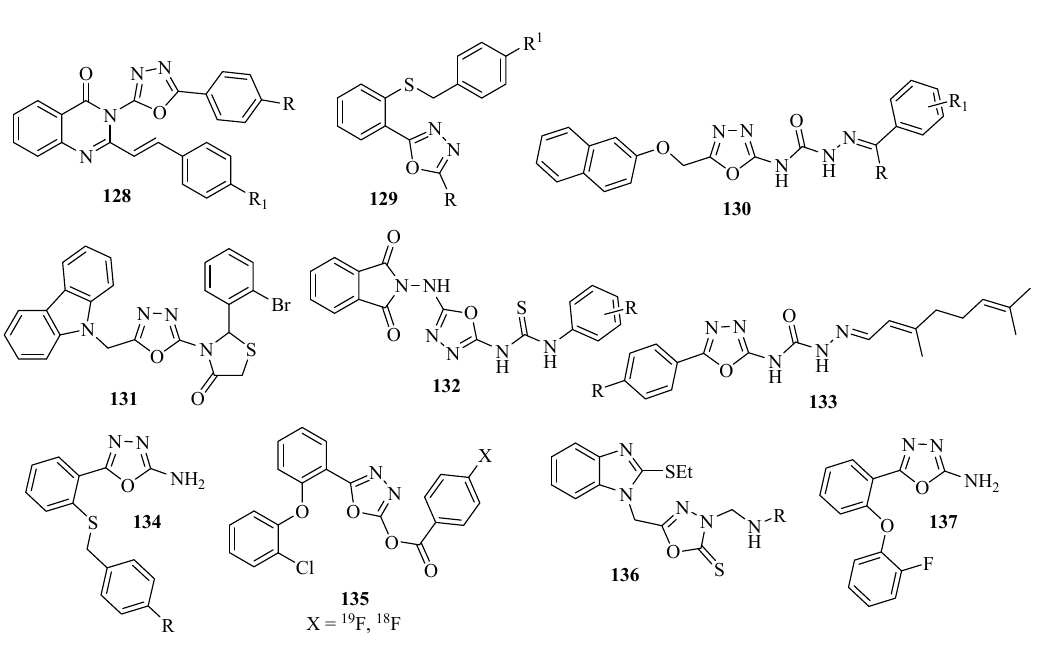
Figure 7. 1,3,4 - Oxadiazoles with anticonvulsant